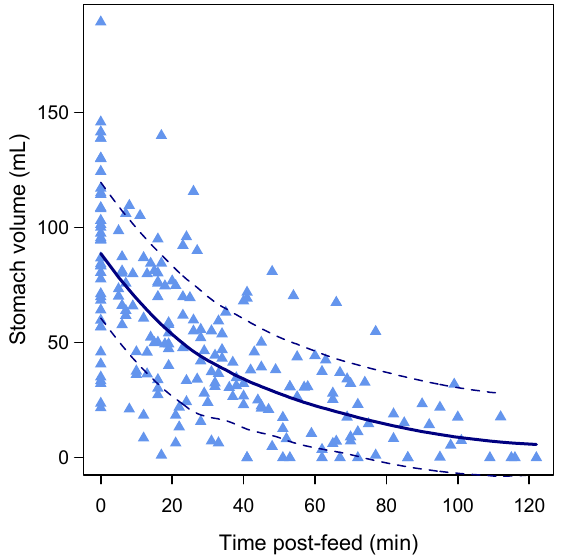
Figure 2. Overall curvilinear pattern of gastric emptying ( n = 41 feeds). The lines represent the overall pattern of changes in stomach volume as measured by ultrasound imaging. Bold line represents local regression smoother (LOESS, span = 0.9). Dotted lines represent confidence interval.